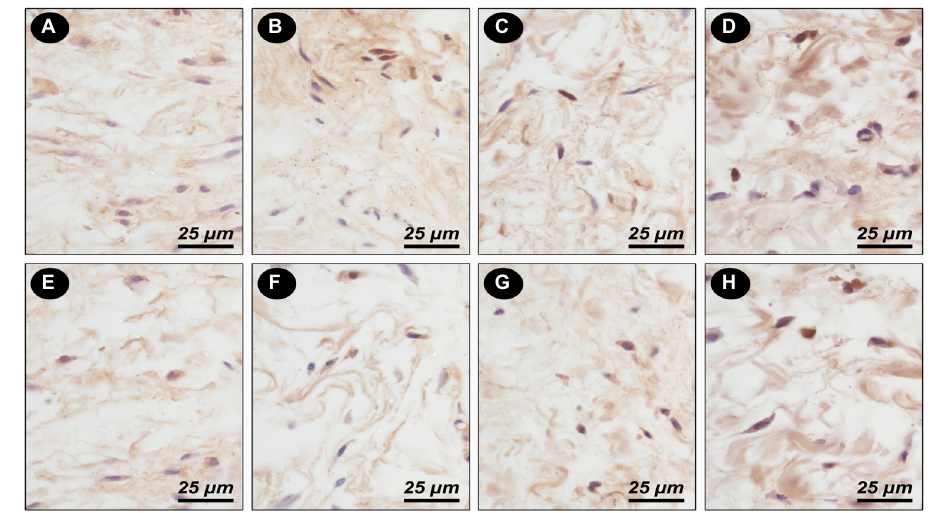
Fig. 2 Photomicrographs showing the immunoreactive cells (arrow- heads) for TNF- α ( A – D ); IL-1 β ( E – H ) at 30 days for control ( A , E ); Ambroxol-associated Propylene Glycol ( B , F ); Ambroxol-associated